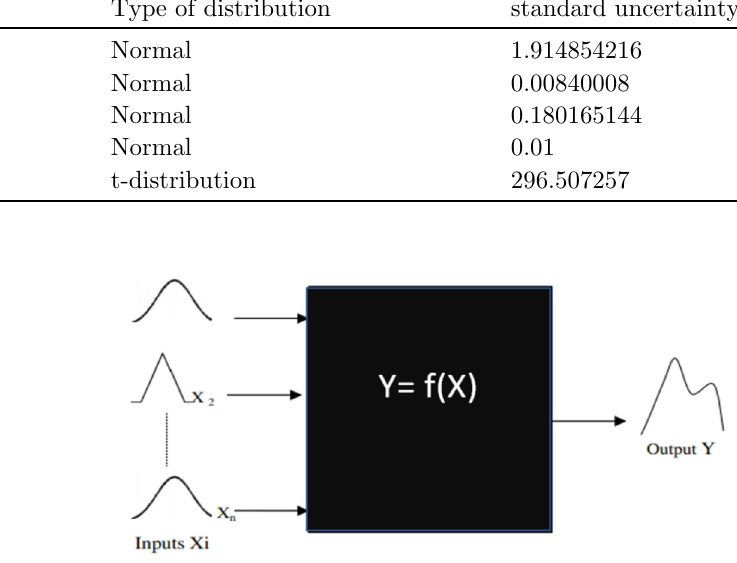
Fig. 5. Propagation of uncertainty model.